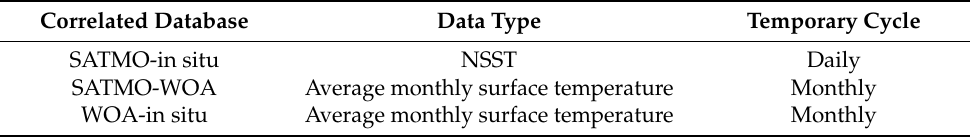
Table 3. Simple linear correlation of databases and in situ data.